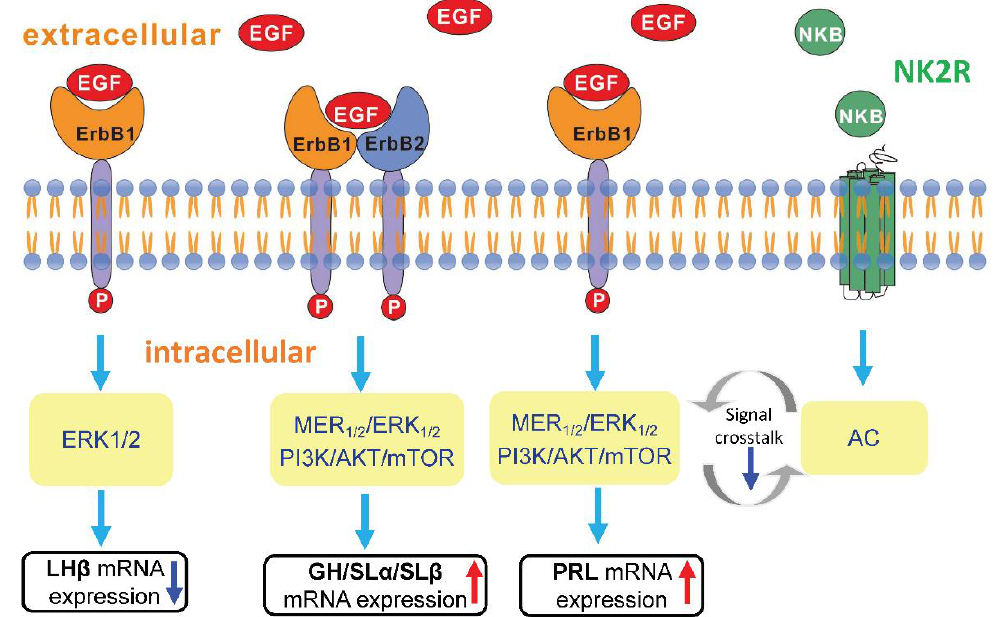
Figure 8. Working modal of pituitary hormones regulation by EGF in grass carp pituitary cells. EGF-reduced LHβ mRNA expression was mediated by ErbB1 homodimerization coupled to ERK 1/2 pathway. EGF-induced GH, SLα and SLβ mRNA expression were mediated by ErbB1 and ErbB2 heterodimerization coupled to MEK 1/2 /ERK 1/2 pathway and PI 3 K/Akt/mTOR pathway, respectively. EGF-induced PRL release and mRNA expression was mediated by ErbB1 via MEK 1/2 /ERK 1/2 pathway and PI 3 K/Akt/mTOR pathway. In addition, the inhibitory effect of NKB on EGF-induced PRL mRNA expression was mediated by NK2R coupled to AC/cAMP/PKA pathway. The blue down arrows were represented by down-regulation and the red up arrows were represented by up-regulation. The grey circle arrows were indicated that the hypothesis of cross-talk among signal pathways.